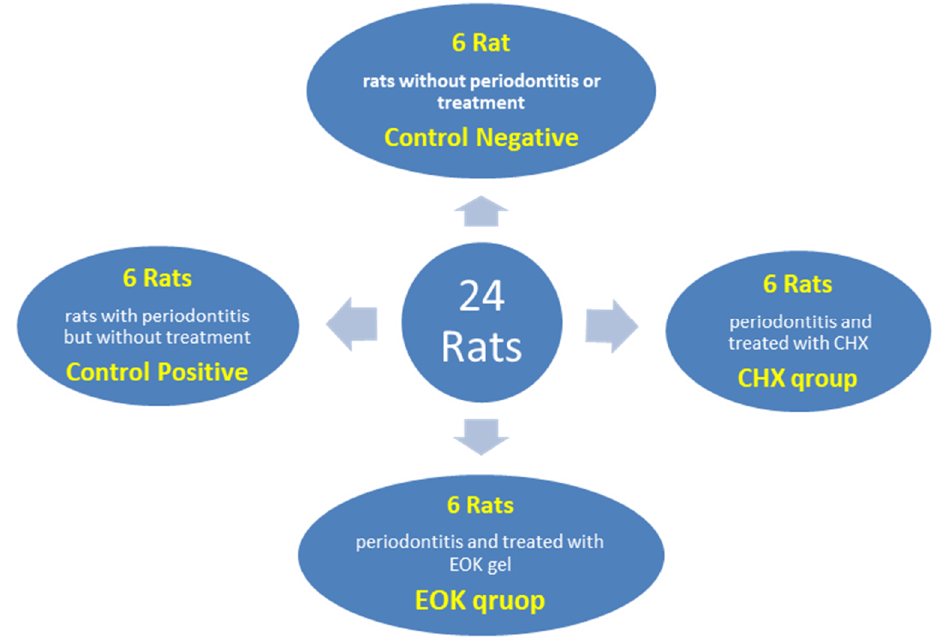
Figure 5. Experimental design of the studied groups.